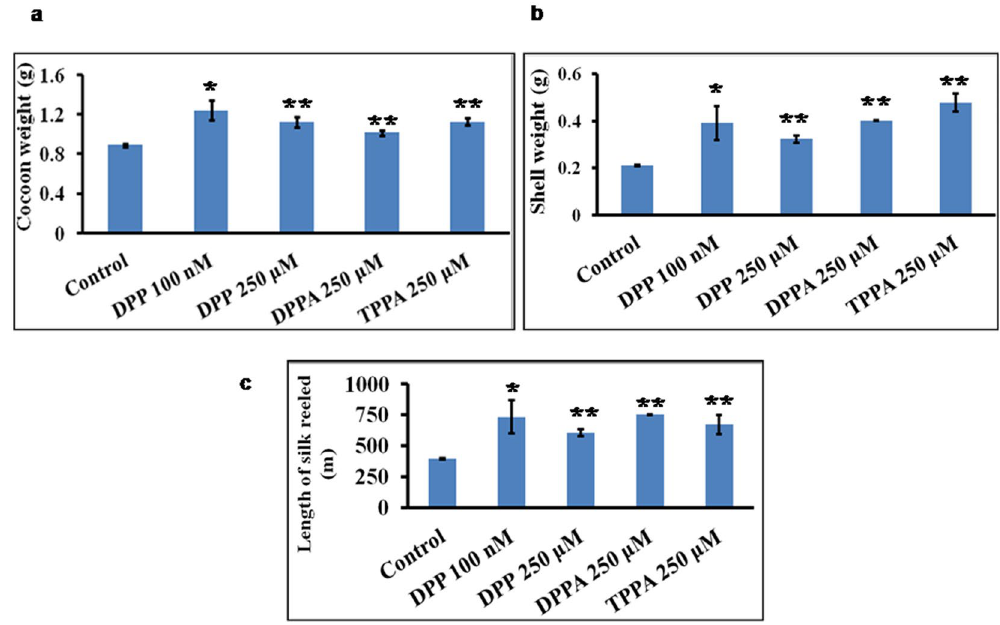
Figure 6. Effect of DPP , DPPA , and TPPA on various growth parameters related to silk economics; ( a ) the cocoon weight ( b ) the shell weight and ( c ) the length of silk reeled. Biological replicates of control and drug treated groups were conducted each time. The data of one biological replicate (control and different drug treated groups) was analysed by one way ANOVA and student’s t -test (Two-Sample Assuming Equal Variances). The bars labeled with ‘ * ’ are significantly different ( p < 0.05) and labeled with ‘ ** ’ have p <